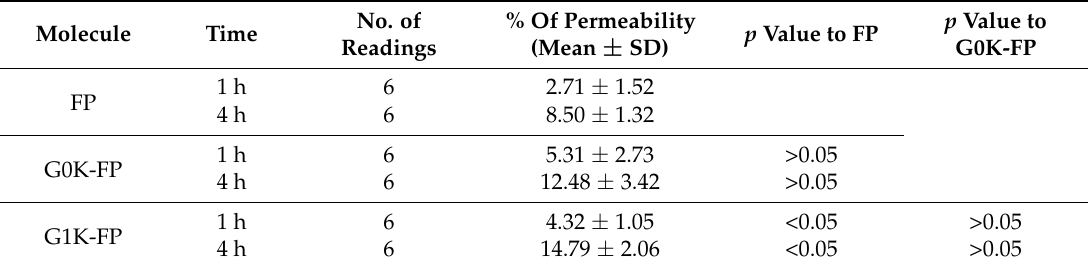
Table 1. Permeability % of flurbiprofen (FP) and FP-loaded dendrons across an in vitro blood-brain barrier (BBB) model.